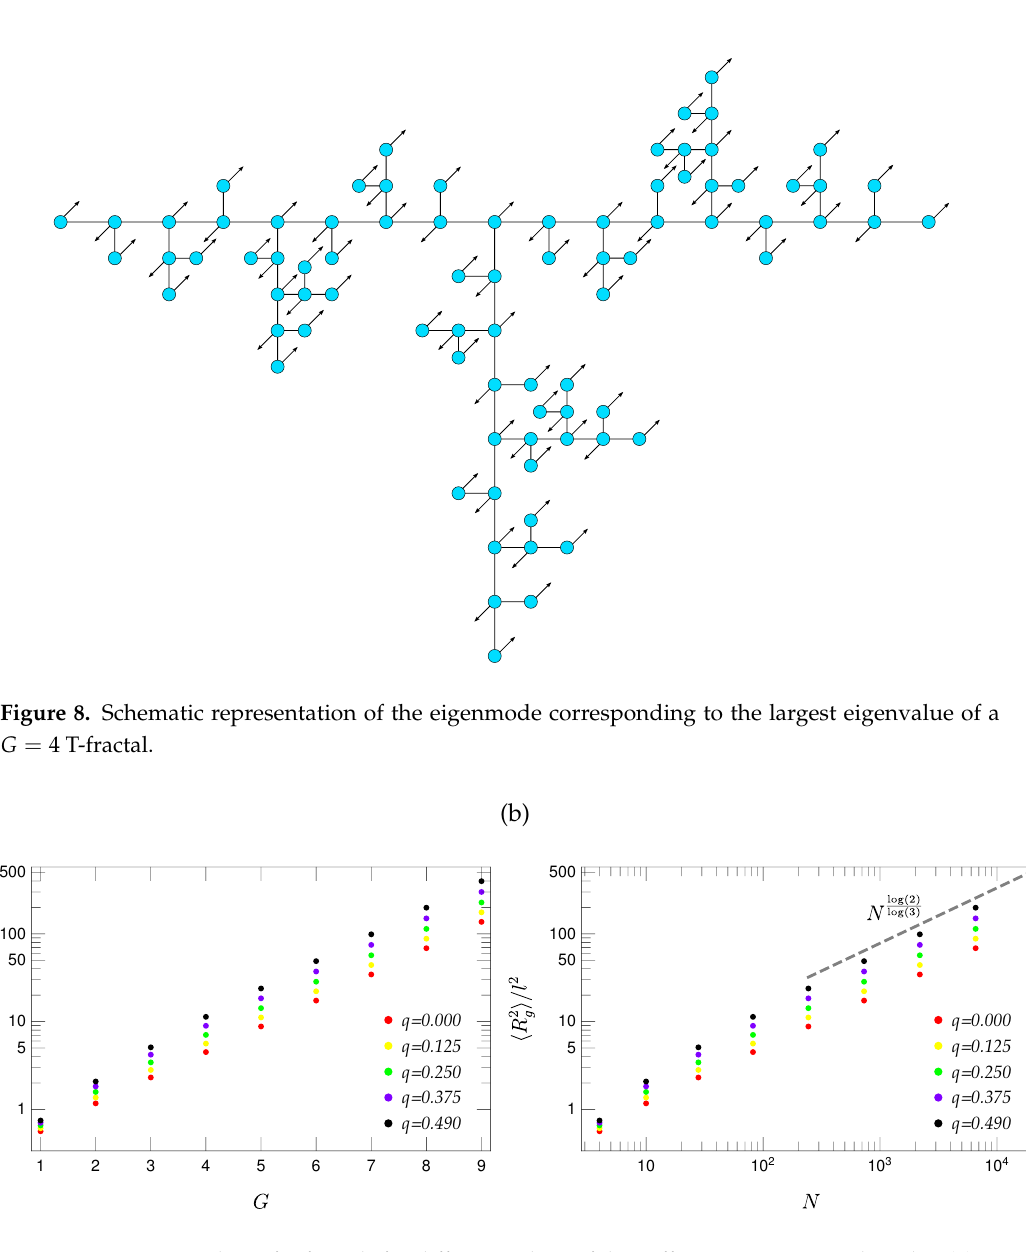
Figure 9. Gyration radius of T-fractals for different values of the stiffness parameter q plotted in (a) as a function of generation G and in (b) as a function of number of beads N .